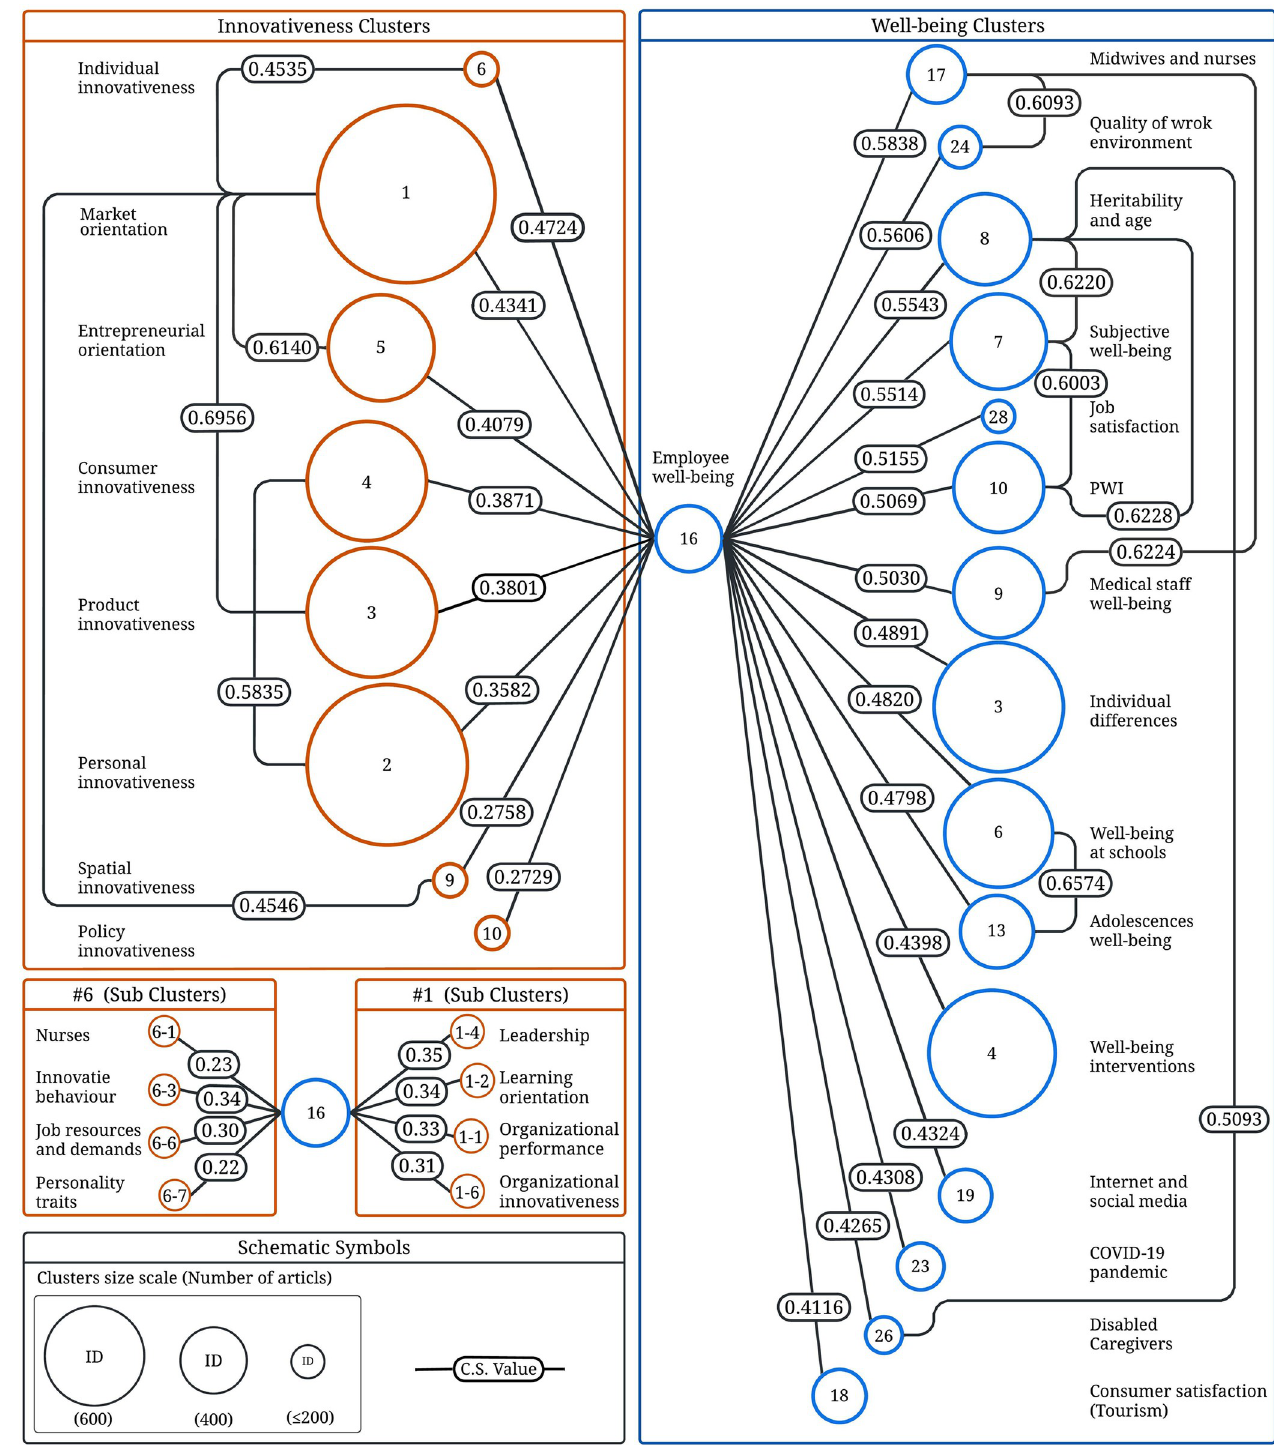
Fig 3. Schematic showing all clusters that share a cosine similarity value (with employee well-being) above the thresholds (third quartile). Relative clusters size and high cosine similarity values between clusters are also depicted.